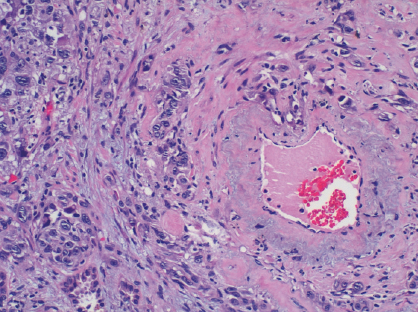
Figure 3: H-E staining of the fistula with large and irregular cells with prominent nucleoli and